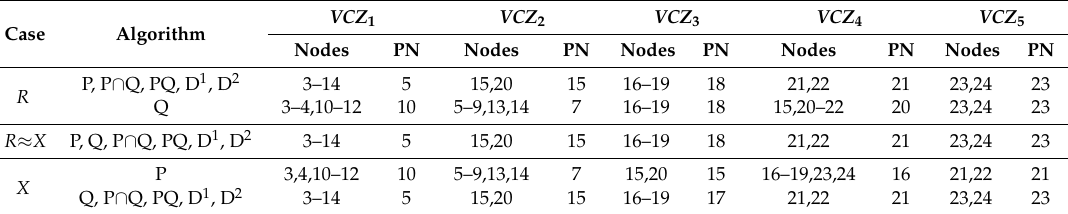
Table 5. Nodes and pilot nodes for five VCZs.